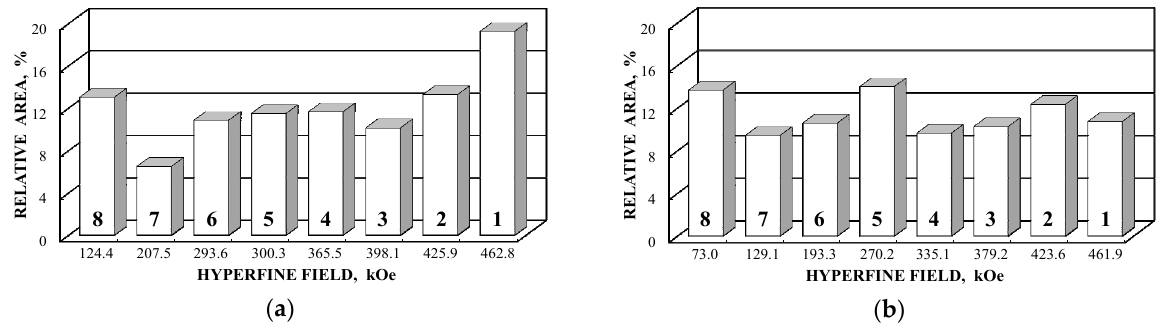
Figure 45. Histograms of the distributions of the relative areas of magnetic sextets in the order of increase in the H eff values for corresponding spectral components revealed from the Mössbauer spectra of the FM ( a ) and FMC ( b ) nanoparticles measured at 295 K (the numbers of sextets are the same as indicated in Figure 44).